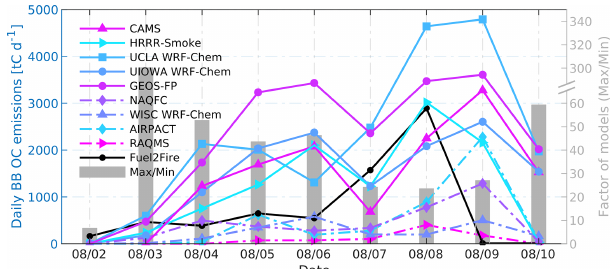
Figure 3. Time series of daily total biomass burning OC emissions from the Williams Flats fire predicted in different models. Models using FRP-based emissions are shown with solid lines, and those using hotspot-based emissions are shown with dashed–dotted lines. The solid black line with dots stands for Fuel2Fire emissions anal- ysis. Grey bars represent factors between the maximum and mini- mum for all